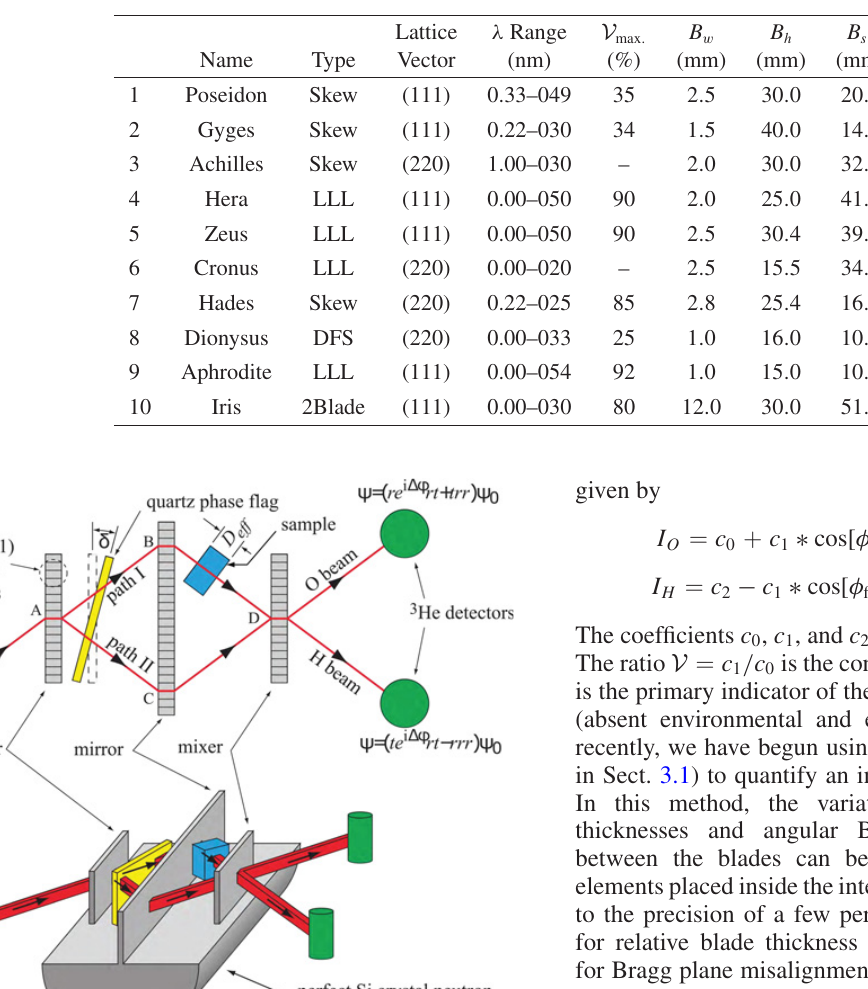
Table 1. List of interferometers. Blade width B w , height B h and separation B s 1 , s 2 are shown. The maximum V is the largest value that has been observed for any wavelength. Interferometers with contrasts unspecified have either not been used in the last 15 years at NIST and/or are believed to be < 10%. Updated from Ref. [4].